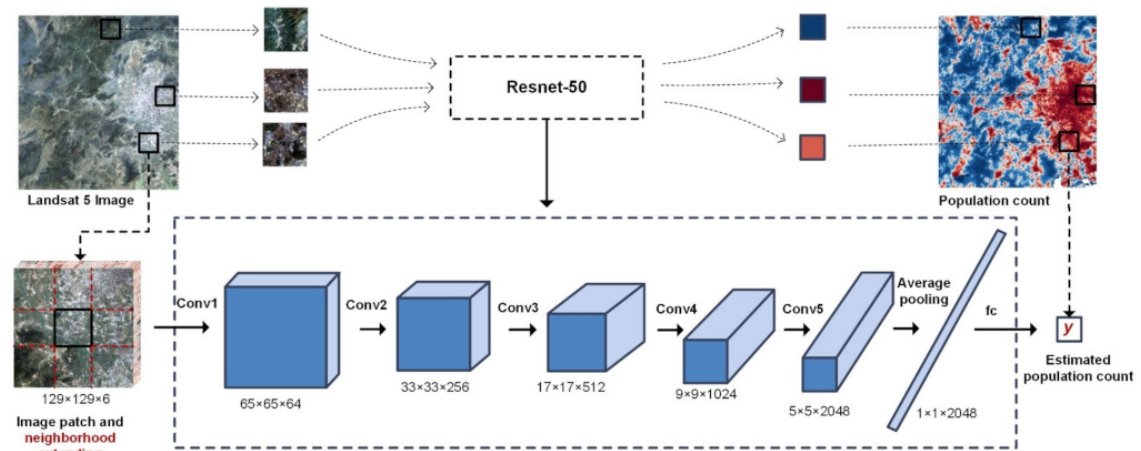
Figure 6. An end-to-end ResNet-N model to estimate population count from RS images by embedding the neighbor knowledge into